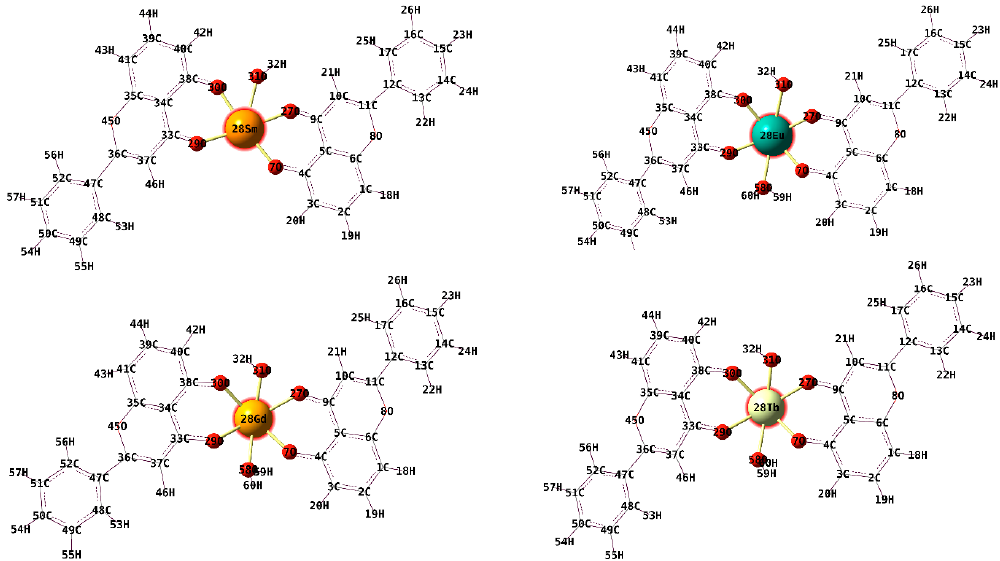
Figure 4. The optimised structure of the electronic ground state of 5-hydroxyflavone at the B3LYP level of theory (6-31G(d) basis).